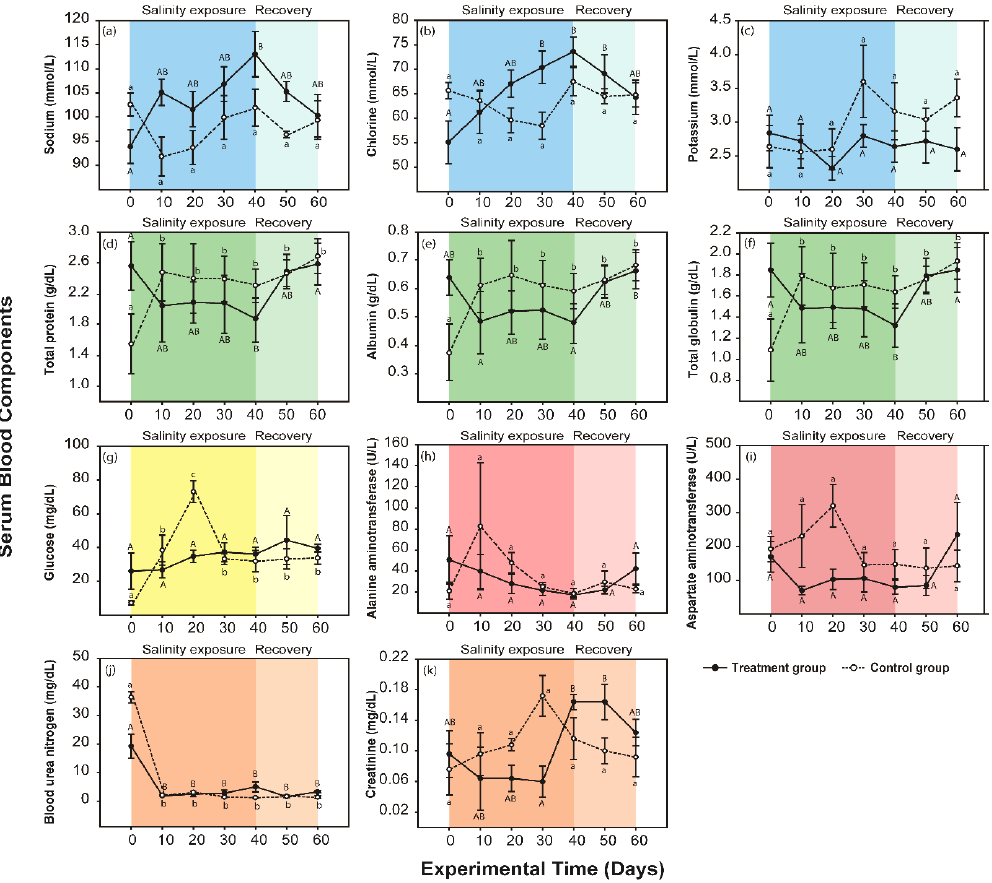
Figure 3. Graphs of 11 blood serum component levels (means ± SE) after salinity exposure under the moderate condition (black lines and points) and in the control group (dotted lines and white points) in P. nigromaculatus . The dark color indicates a treatment period, while the relatively light color indicates a recovery period. The blue graphs depict the changes in serum electrolytes: ( a ) sodium (mmol/L), ( b ) chlorine (mmol/L), and ( c ) potassium (mmol/L). The green graphs depict the changes in serum protein: ( d ) total protein (g/dL), ( e ) albumin (g/dL), and ( f ) total globulin (g/dL). The yellow graph represents the change in a serum nutrient, ( g ) glucose (mg/dL). The red graphs depict the changes in liver function according to ( h ) alanine aminotransferase (ALT, U/L) and ( i ) aspartate aminotransferase (AST, U/L). The orange graphs depict the changes in renal function according to ( j ) blood urea nitrogen (BUN, mg/dL) and ( k ) creatinine (mg/dL). Significant differences ( p < 0.05) are indicated by capital letters in the experimental group and by lowercase letters in the control group according to Tukey’s post hoc tests.